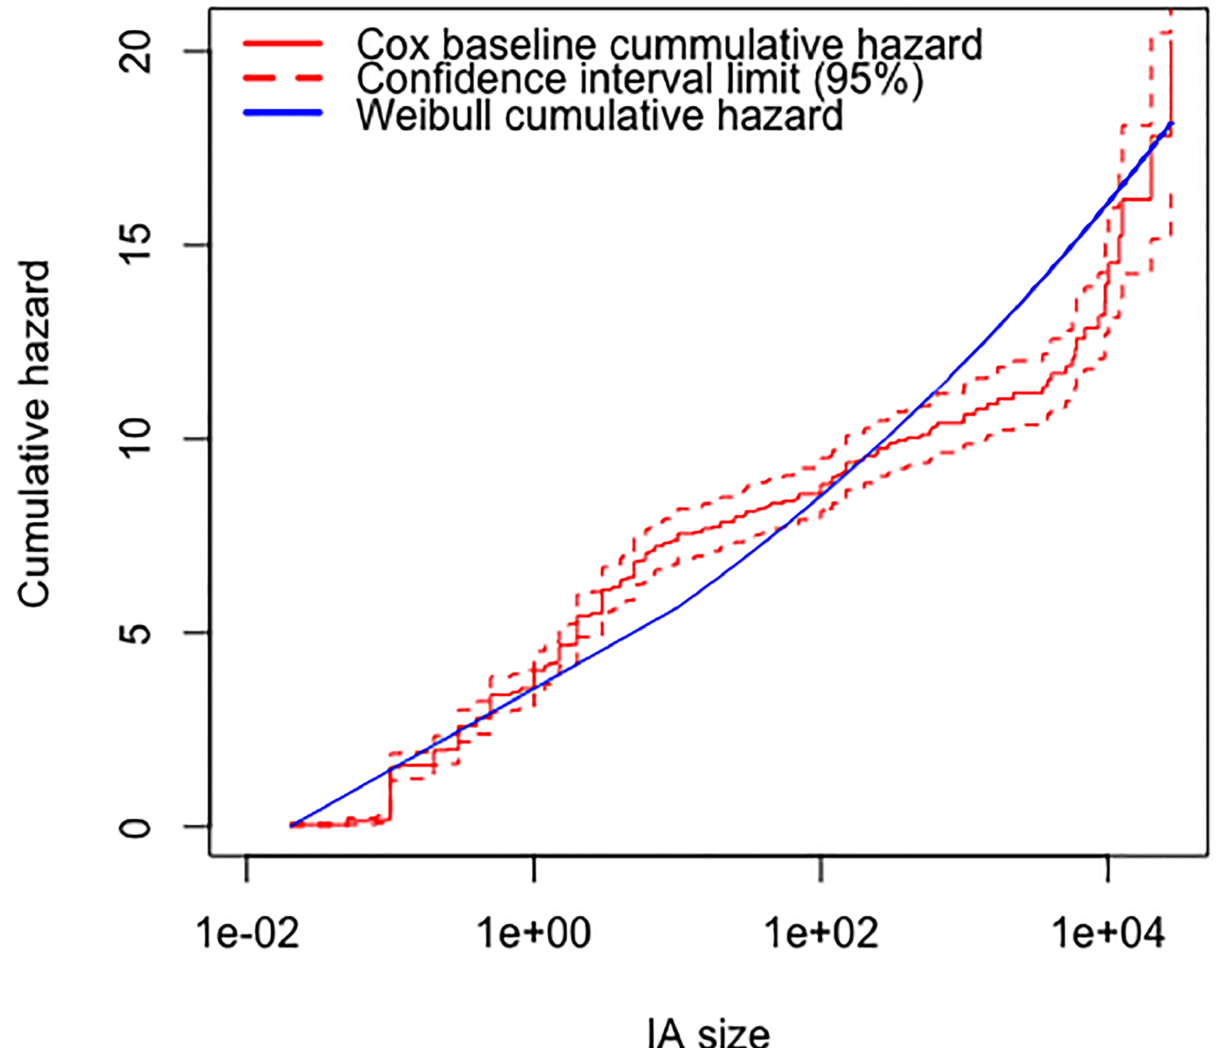
Fig 3. Comparison of Cox PH baseline cumulative hazard and Weibull cumulative hazard. The Weibull cumulative hazard line is often outside the nonparametric 95% (red dashed line) confidence bands for this cumulative hazard function, while the Cox PH baseline cumulative hazard stays within the bands, strongly suggesting that the Cox PH model fits the data better than the